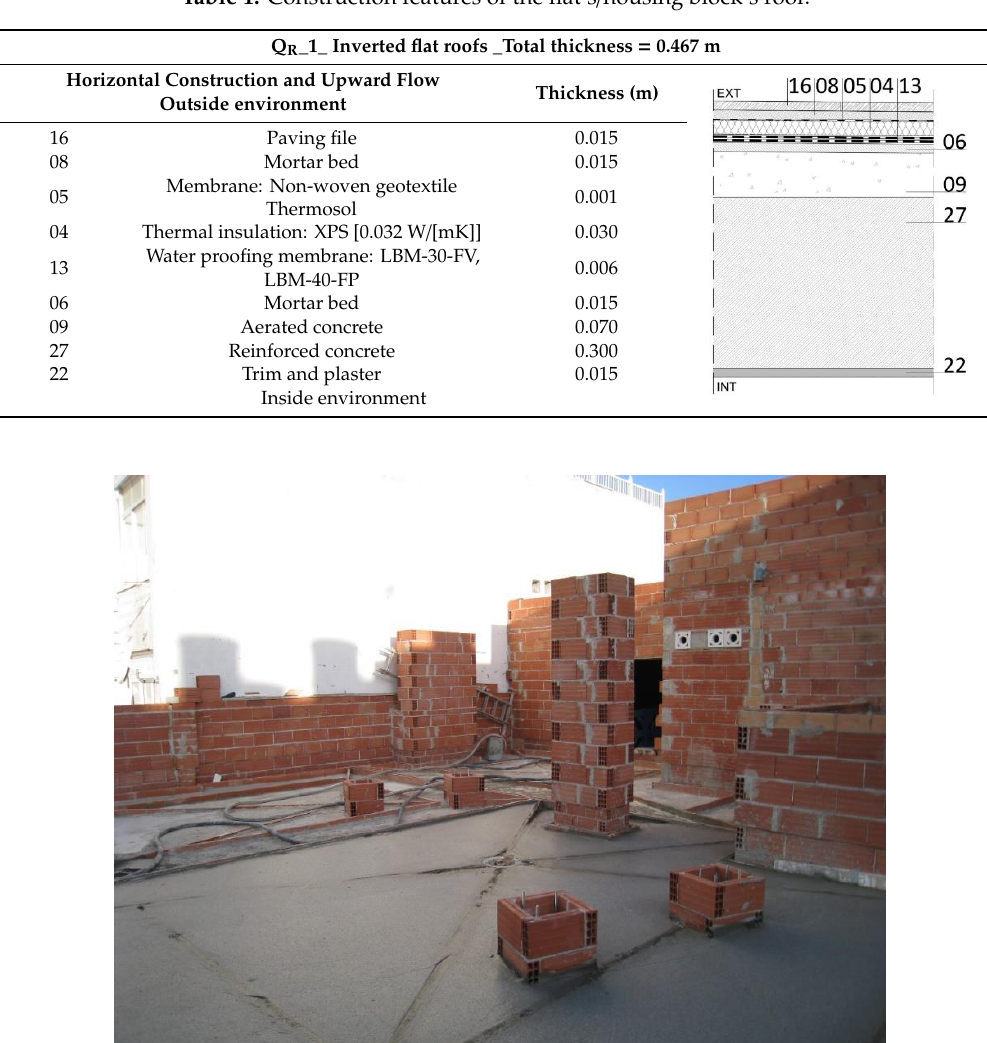
Figure 2. Image of the construction of walkable inverted flat roof of a housing block.